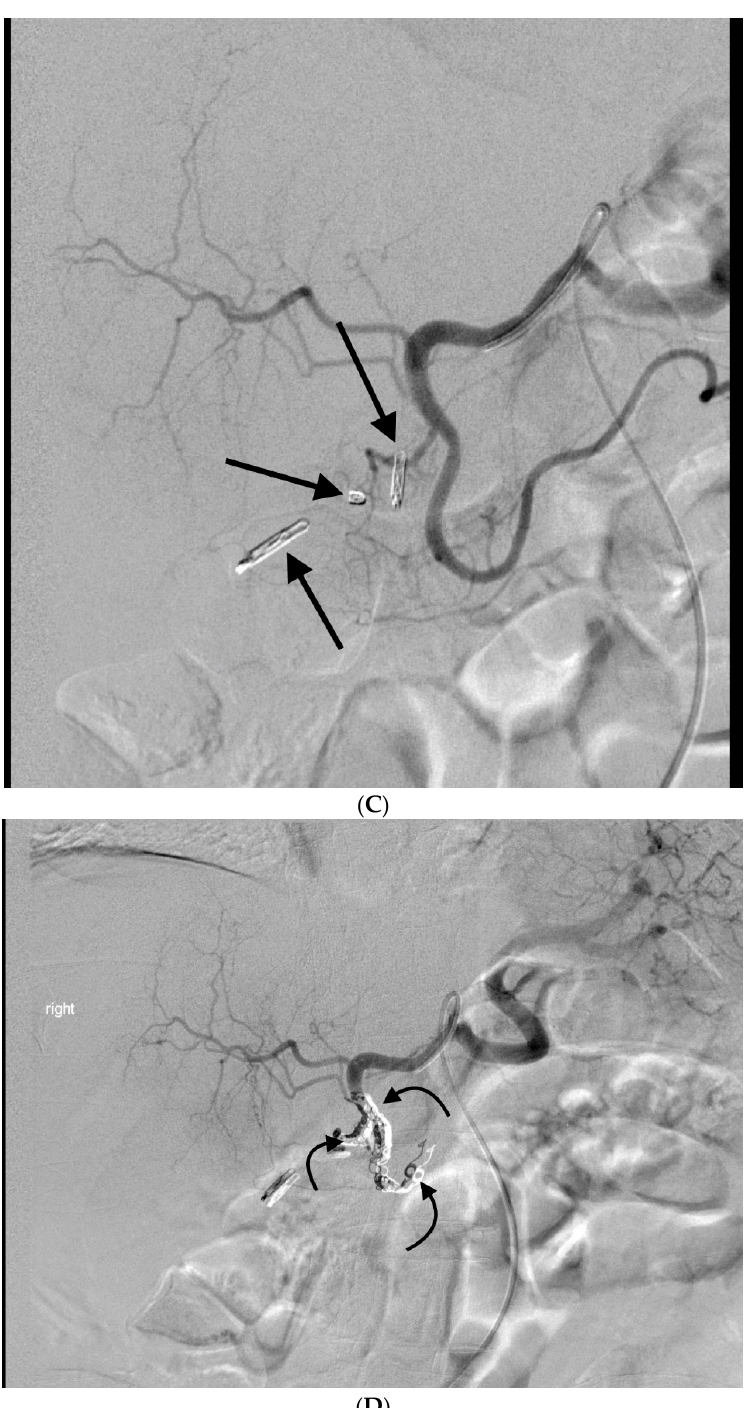
Figure 1. This 72 year old man presented with hematemesis and melena. ( A ) He underwent an upper endoscopy, at which time blood was seen in the duodenal bulb with two cratered oozing ulcers present. The largest ulcer was 10 mm in diameter. ( B ) The ulcers were treated with an injection of 4cc of 1:10,000 epinephrine, followed by the placement of hemostatic clips. ( C ) While hemostasis was achieved at the time of endoscopy, the patient rebled 3 h later. An angiogram shows multiple endoscopic clips (black arrows) in the duodenum, a region supplied by the gastrodoudenal artery (GDA). These clips helped to guide the angiographer to the location of the bleed. The ( D ) coil (curved black arrows) and gelfoam embolization was performed on the GDA.